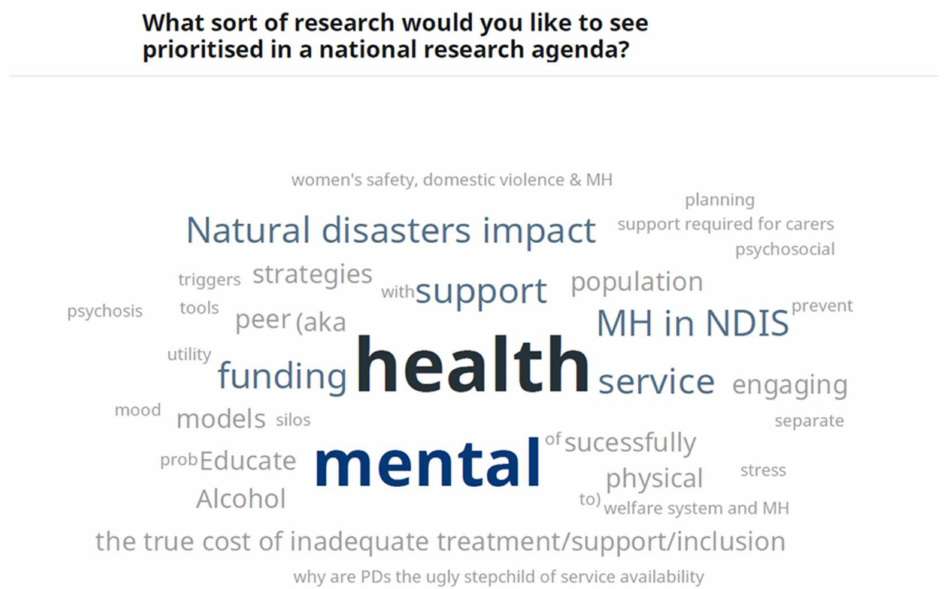
Figure 1. Slido poll for question 2 (Group 2; n =